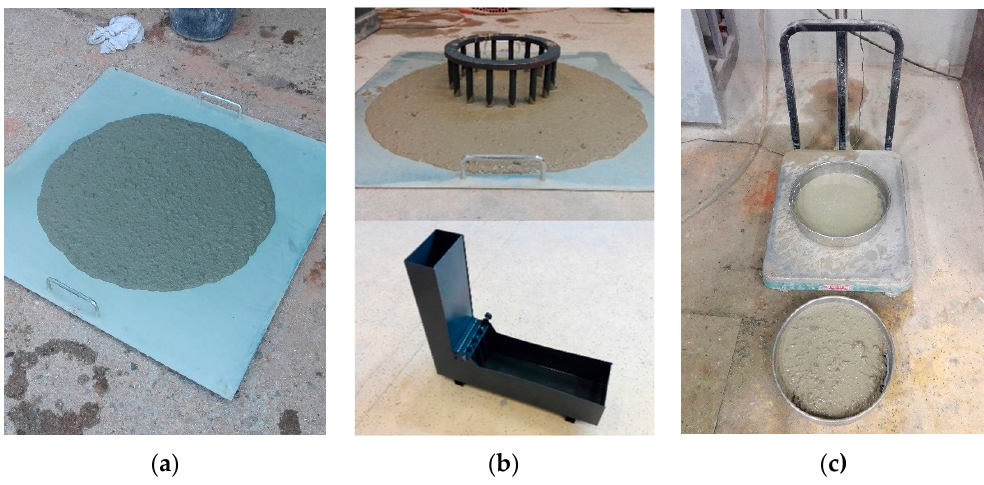
Figure 5. Test of fresh self-compacting concrete: ( a ) flowability and viscosity (slump flow test); ( b ) passing ability (J-ring and L-box); ( c ) segregation resistance (sieve segregation test). Compressive strength (f ck,cyl ) was determined through testing cylinders (Figure 6a) with the dimensions of Ø150 × 300 mm using EN 12390-3:2009 [57]. Flexural strength (f b ) was tested on 100 × 100 × 400 mm prisms (Figure 6b) according to EN 12390-5:2009 [58]. The modulus of elasticity (E) was determined through testing cylinder specimens (Figure 6c) with the dimensions of Ø150 × 300 mm using EN 12390-13:2013